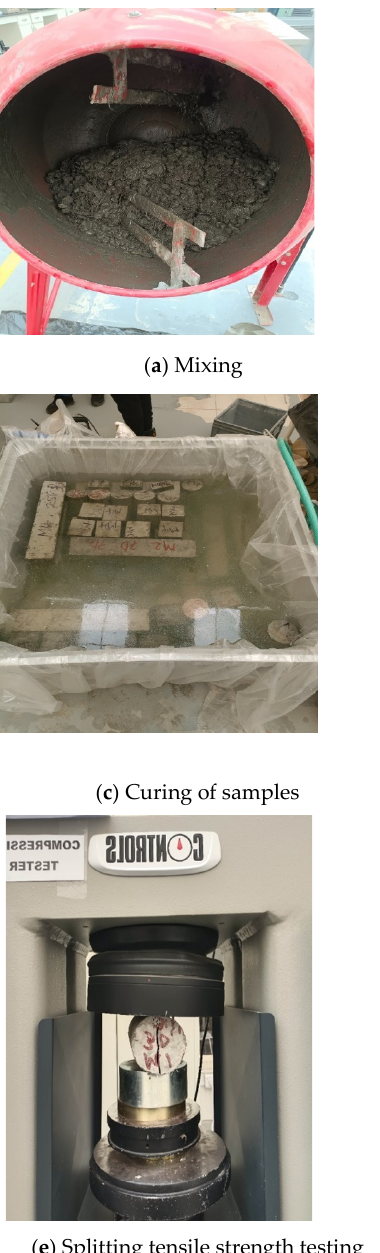
Figure 5. Experimental Set up